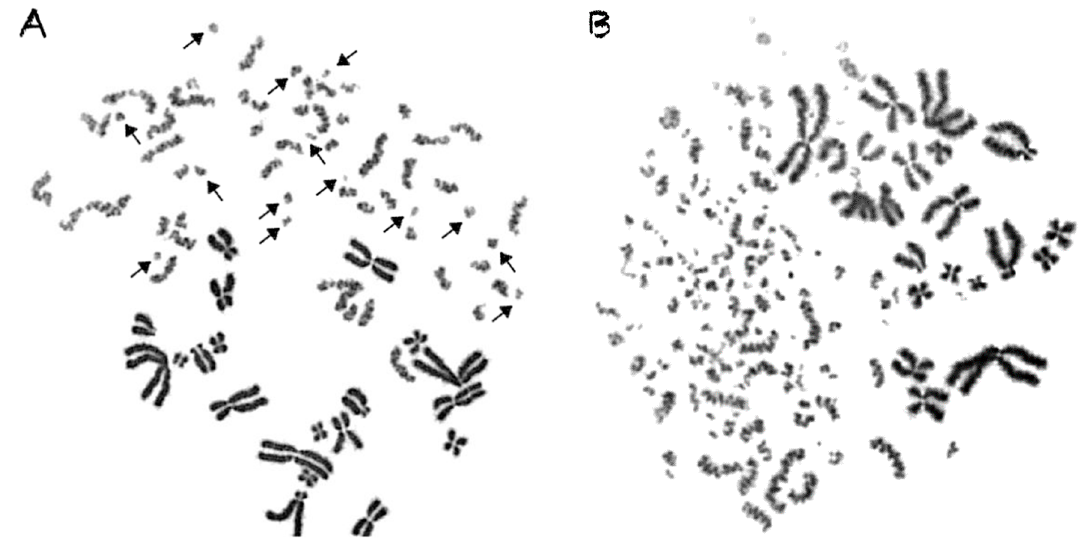
Figure 2. Irradiated peripheral blood G0 lymphocytes with 4 Gy of γ -rays or 6 Gy of α -particles. ( A ) The impact of low-density energy deposition by 4 Gy of γ -rays translates into chromosome fragmentation in interphase lymphocyte PCCs with a sparse distribution among the chromosome domains of the nucleus, as shown by arrows. Fourteen excess (over 46) PCC fragments can be scored. ( B ) In contrast to γ -rays, even high-density energy deposited by 6 Gy of high-LET α -particle radiation induces direct focal clustered DNA lesions. These DNA lesions can be transformed into localized chromosome shattering in the domains along the particle track, leaving thus intact the non-targeted chromosomes, as shown in the lower part of the PCCs in this panel. One hundred excess (over 46) PCC fragments can be scored.